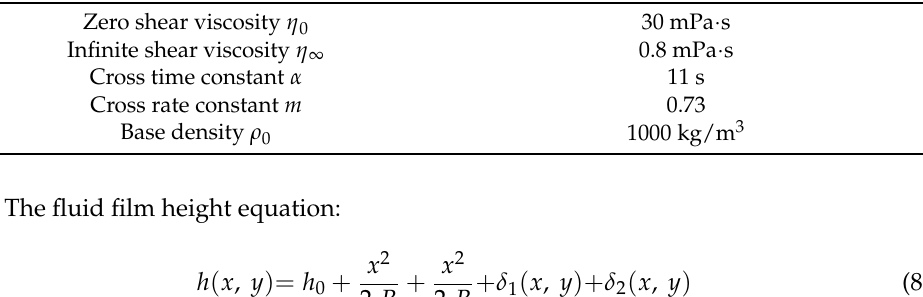
Table 3. Rheological properties of the substitute SF in accordance to [77].